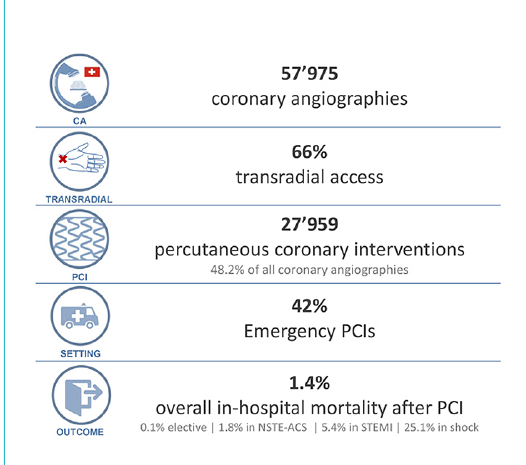
Figure 1: Summary of coronary interventions and their outcomes in Switzerland 2019.